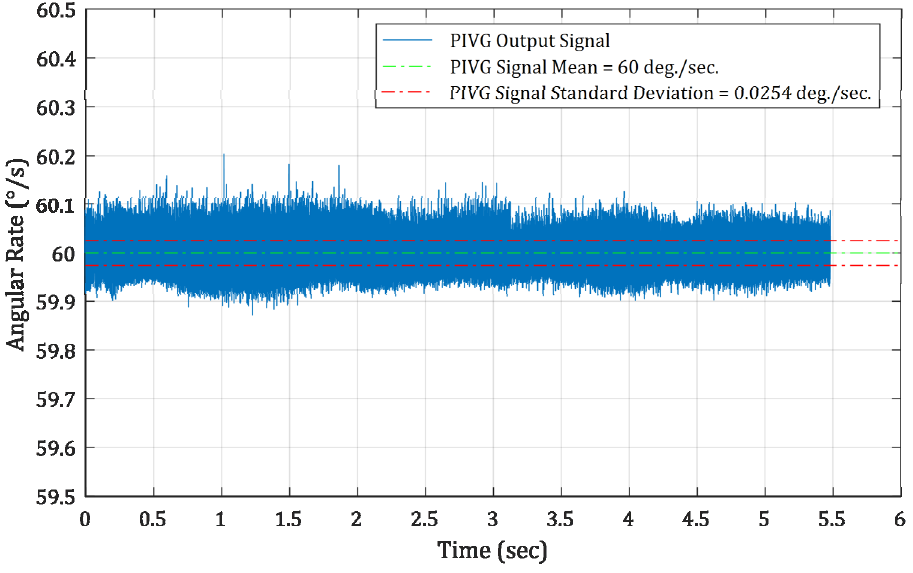
Figure 11. The result of the drift-free validation experiment.